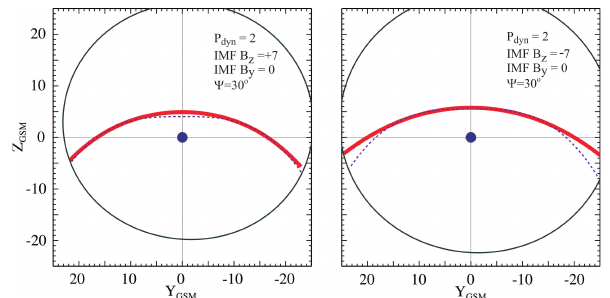
Figure 7. Illustrating the effect of the IMF B z on the global shape of the model surface B r = 0. In both cases P dyn = 2nPa.